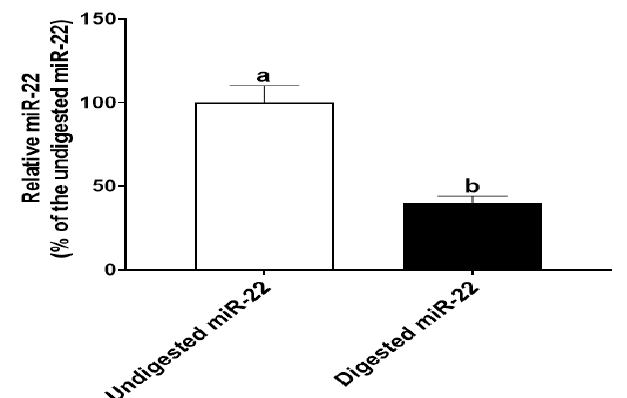
Figure 1. In vitro digestion by HIECs. miR ‐ 22 (in 1 mL infant formula, 30 pmole/mL) was digested with pepsin (pH 4.0) and pancreatin (pH 7.0) for 30 min, respectively. After that, miR ‐ 22 was quan ‐ titated by qRT ‐ PCR. n = 5. Values are shown as mean fold ‐ changes ± SD, relative to the control (set to 1). Bars without a common letter are significantly different ( p <